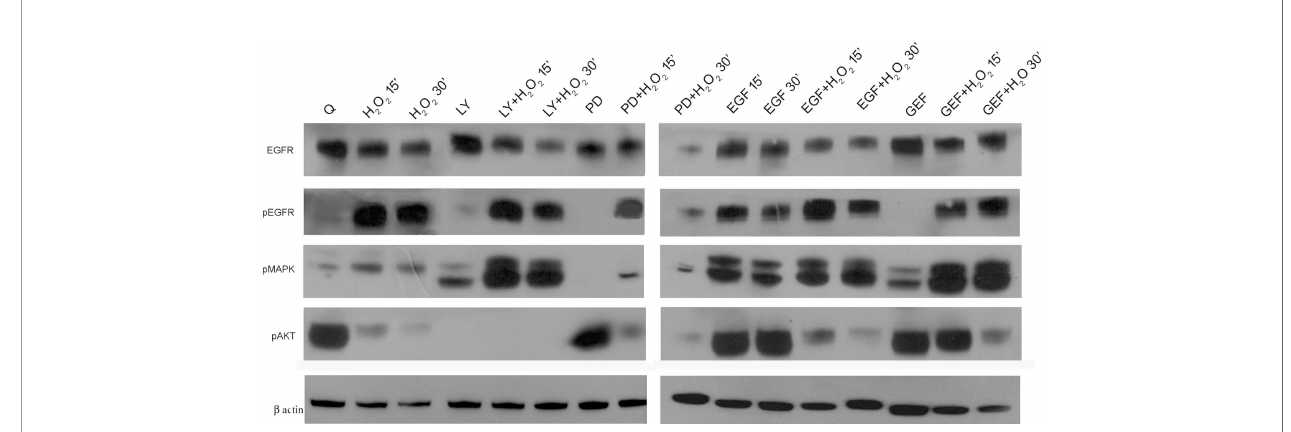
FIGURE 5 | EGFR pathways protein expression analysis. Representative Western blotting of serum-starved cells untreated (Q) and treated with 50 ng/mL EGF, 1 m M ge fi tinib (GEF), 25 m M LY294002 (LY), 50 m M PD98059 (PD), and/or 10 mM H 2 O 2 , for 15 and 30 min. Whole cell lysates were analyzed by Western blotting for expression of total EGFR, phospho (p)EGFR, pMAPK, pAKT, and b -actin (as indicated). Data are representative of six independent experiments. Q, Quiescent; LY, LY294002; PD, PD98059; GEF, ge fi tinib.